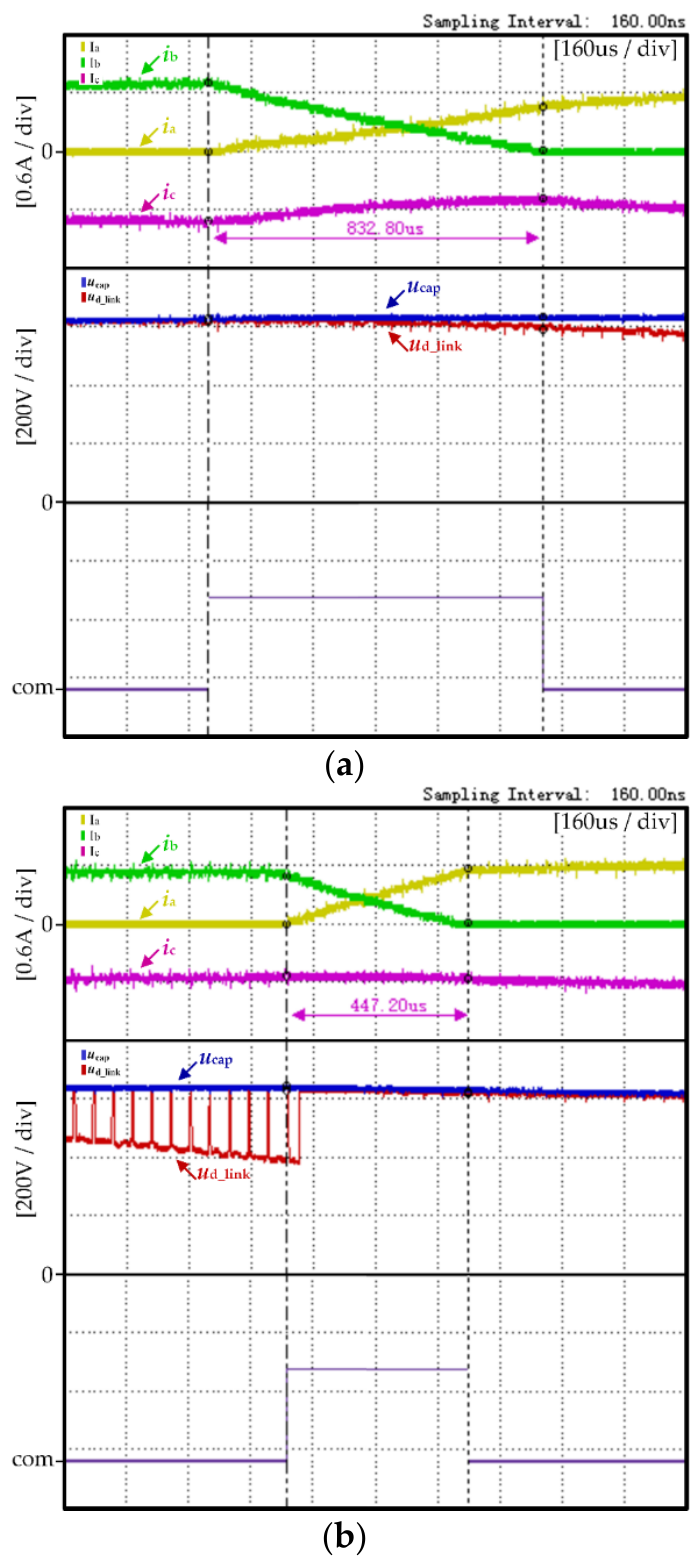
Figure 10. Enlarged view of the experimental results under the high-speed condition (600 r/min, 0.89 N·m): ( a ) traditional strategy ( b ) proposed strategy.